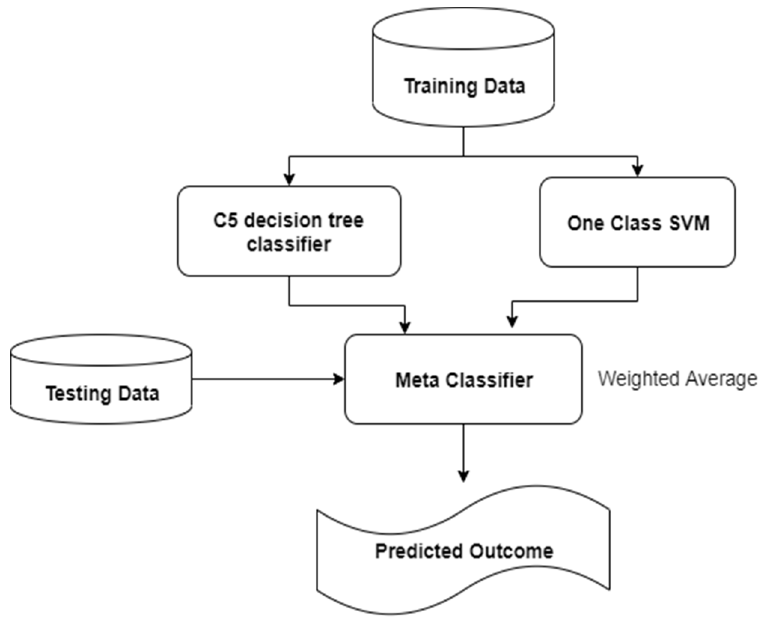
Figure 5. Hybrid Intrusion Detection System based on ensemble of C5 and One-Class SVM.